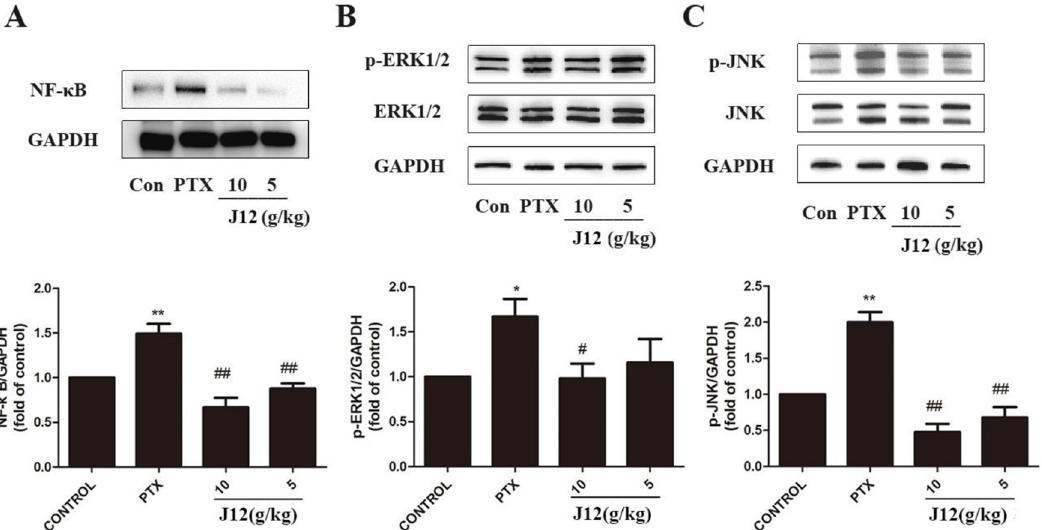
Fig. 2. (A) NF- k B was increased in the mice from PTX group and J12 inhibited the activations. (B) p-ERK1/2 was increased in the mice from PTX group and J12 inhibited the activations. (C) p-JNK was increased in the mice from PTX group and J12 inhibited the activations. n = 5 in each group. * vs Control, p < 0.05; **vs Control, p < 0.01; # vs PTX, p < 0.05. Data are expressed as mean ±